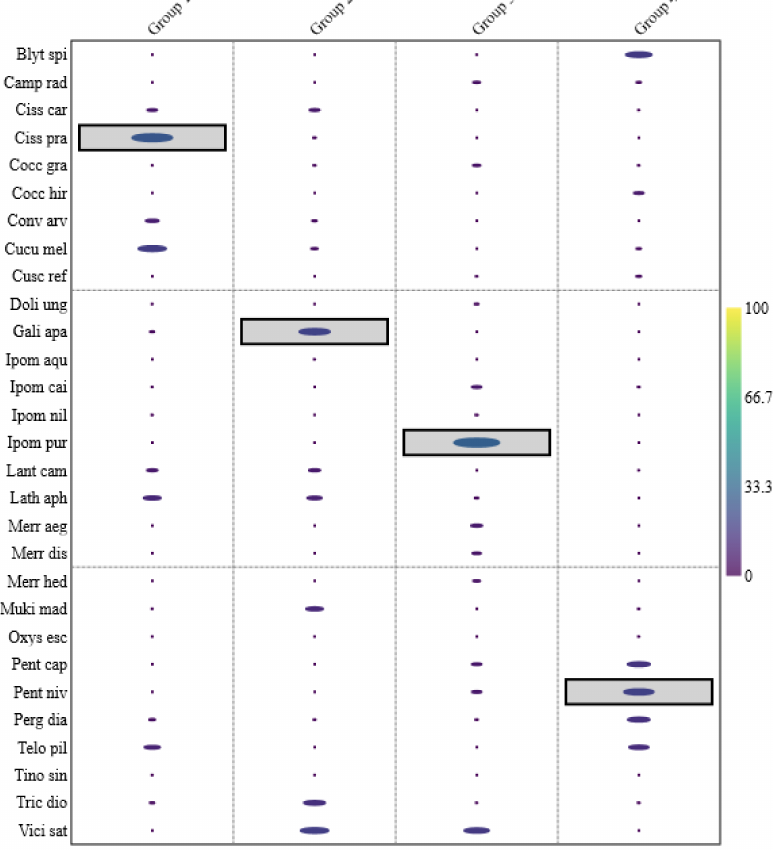
Figure 5. Indicator species in each group. The species highlighted had a significant p -value < 0.05. The color scheme describes the individual value % of plants in four different groups. The letters on the left side of the figures indicate the species code. Full species names are mentioned in Table